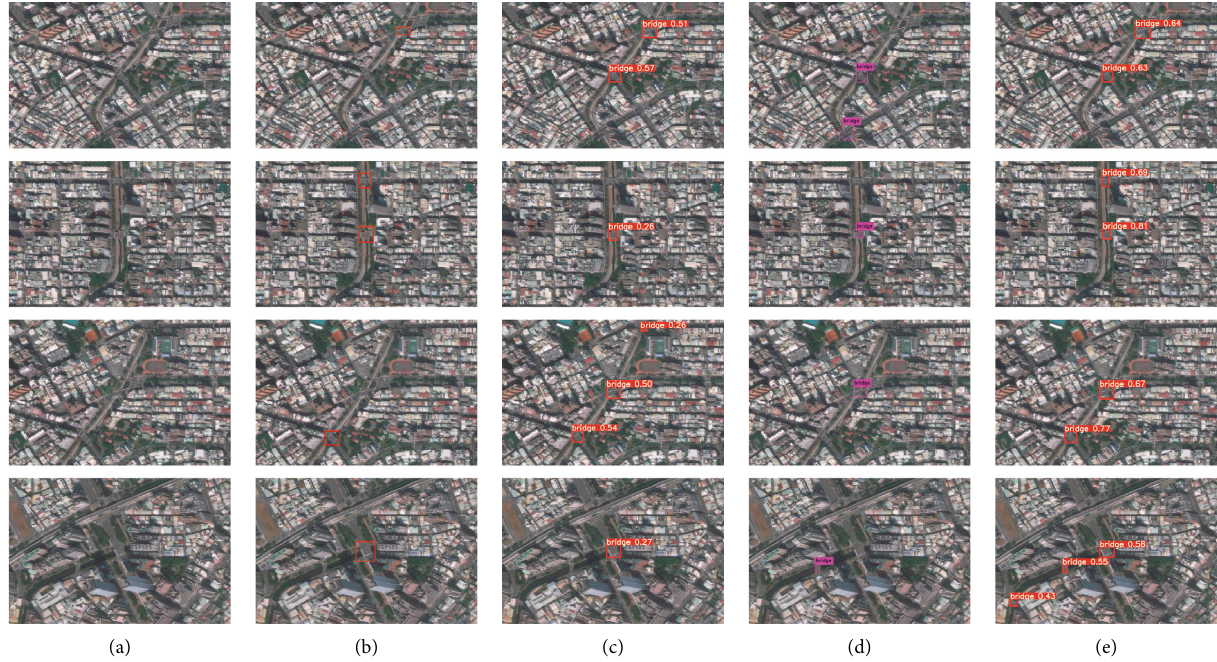
Figure 10: The comparisons of different competing methods for bridge detection under complex backgrounds. From left to right: (a) original images and detected results by (b) Faster R-CNN, (c) YOLOv3, (d) YOLOv4, and (e) YOLOv5s,